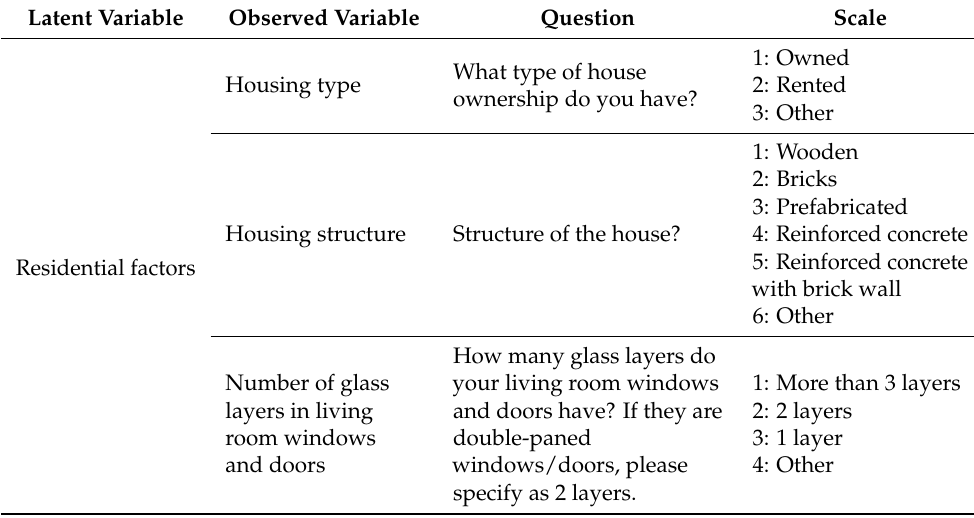
Table 2. Latent and observed variables and their evaluation scale used in the initial SEM